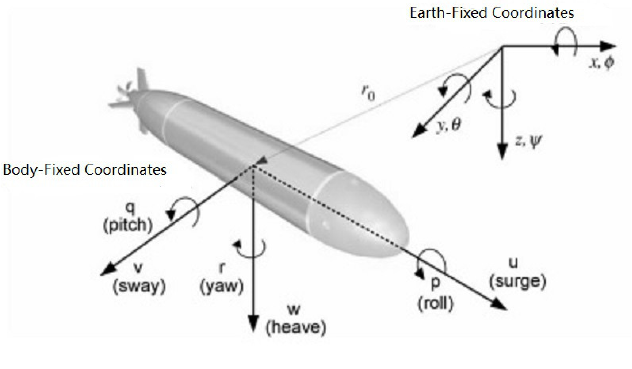
Figure 1. Six DOFs motions of